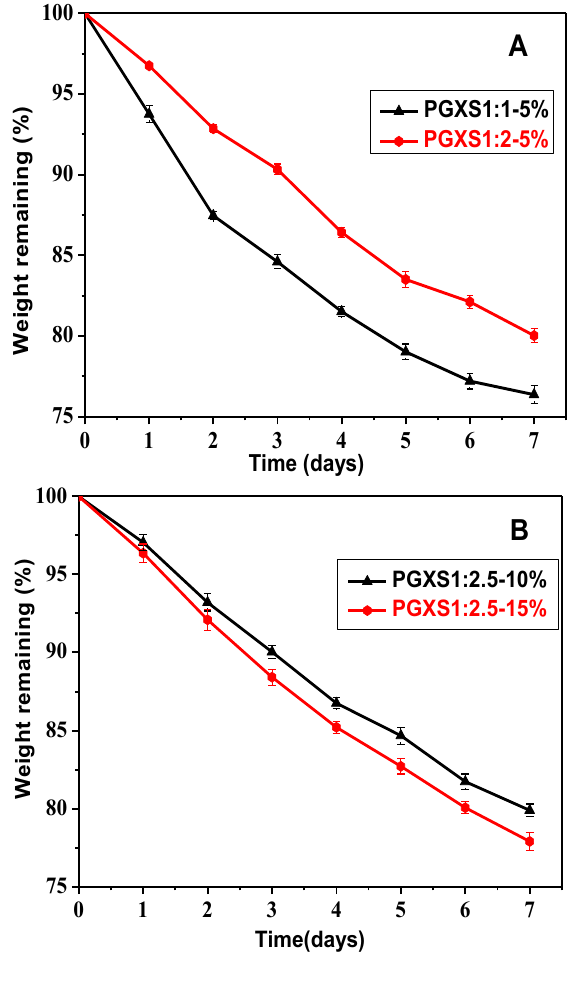
Figure 8. In vitro degradation behavior of PXGS in phosphate-buffered saline (pH = 7.4) at 37 °C for the hydrolysis test. ( A ) PXGS with different xylitol:dicarboxylic acid ratio; and (B) PXGS with different content of Boc- L -glutamic